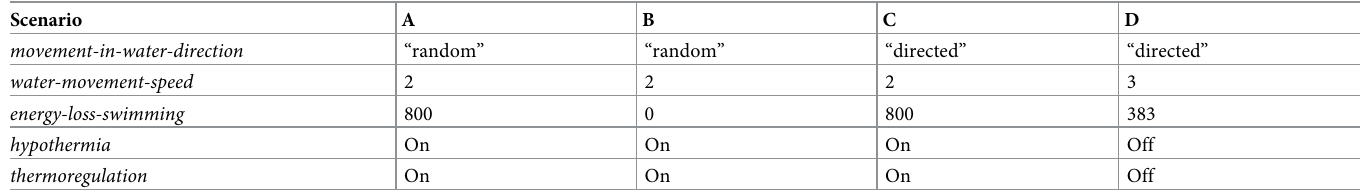
Table 4. The four different behavioral scenarios tested in the simulation experiments and their respective levels of factors. Scenario